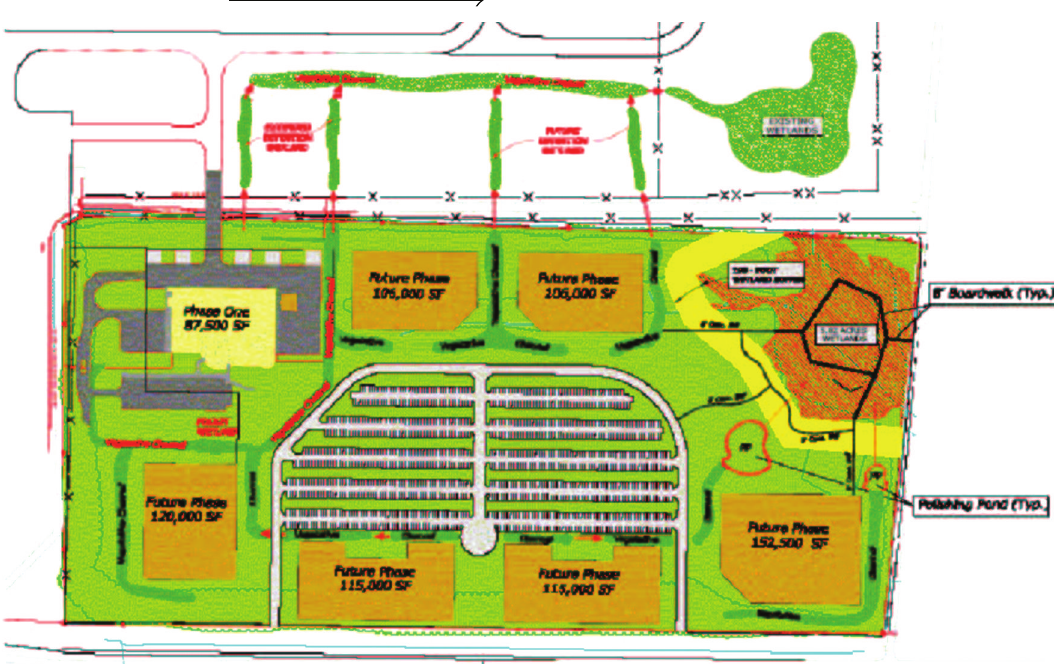
Figure 8: American Eurocopter site layout (Source: